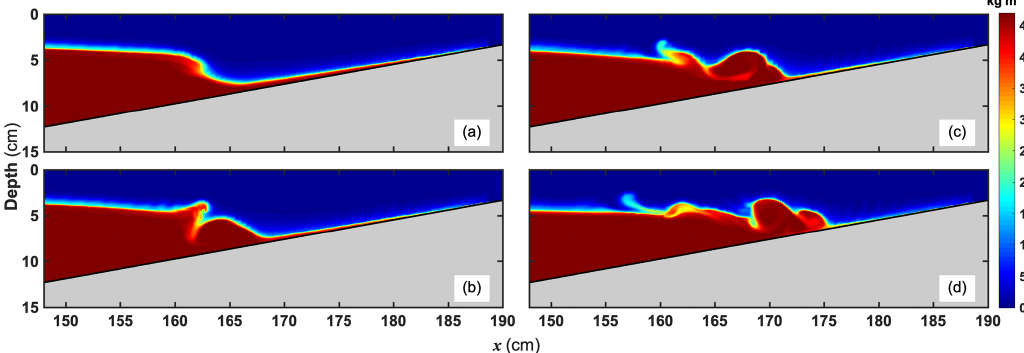
Figure 15. Wave breaking with density front rolling at t = (a) 22, (b) 23, (c) 24, and (d) 25s.